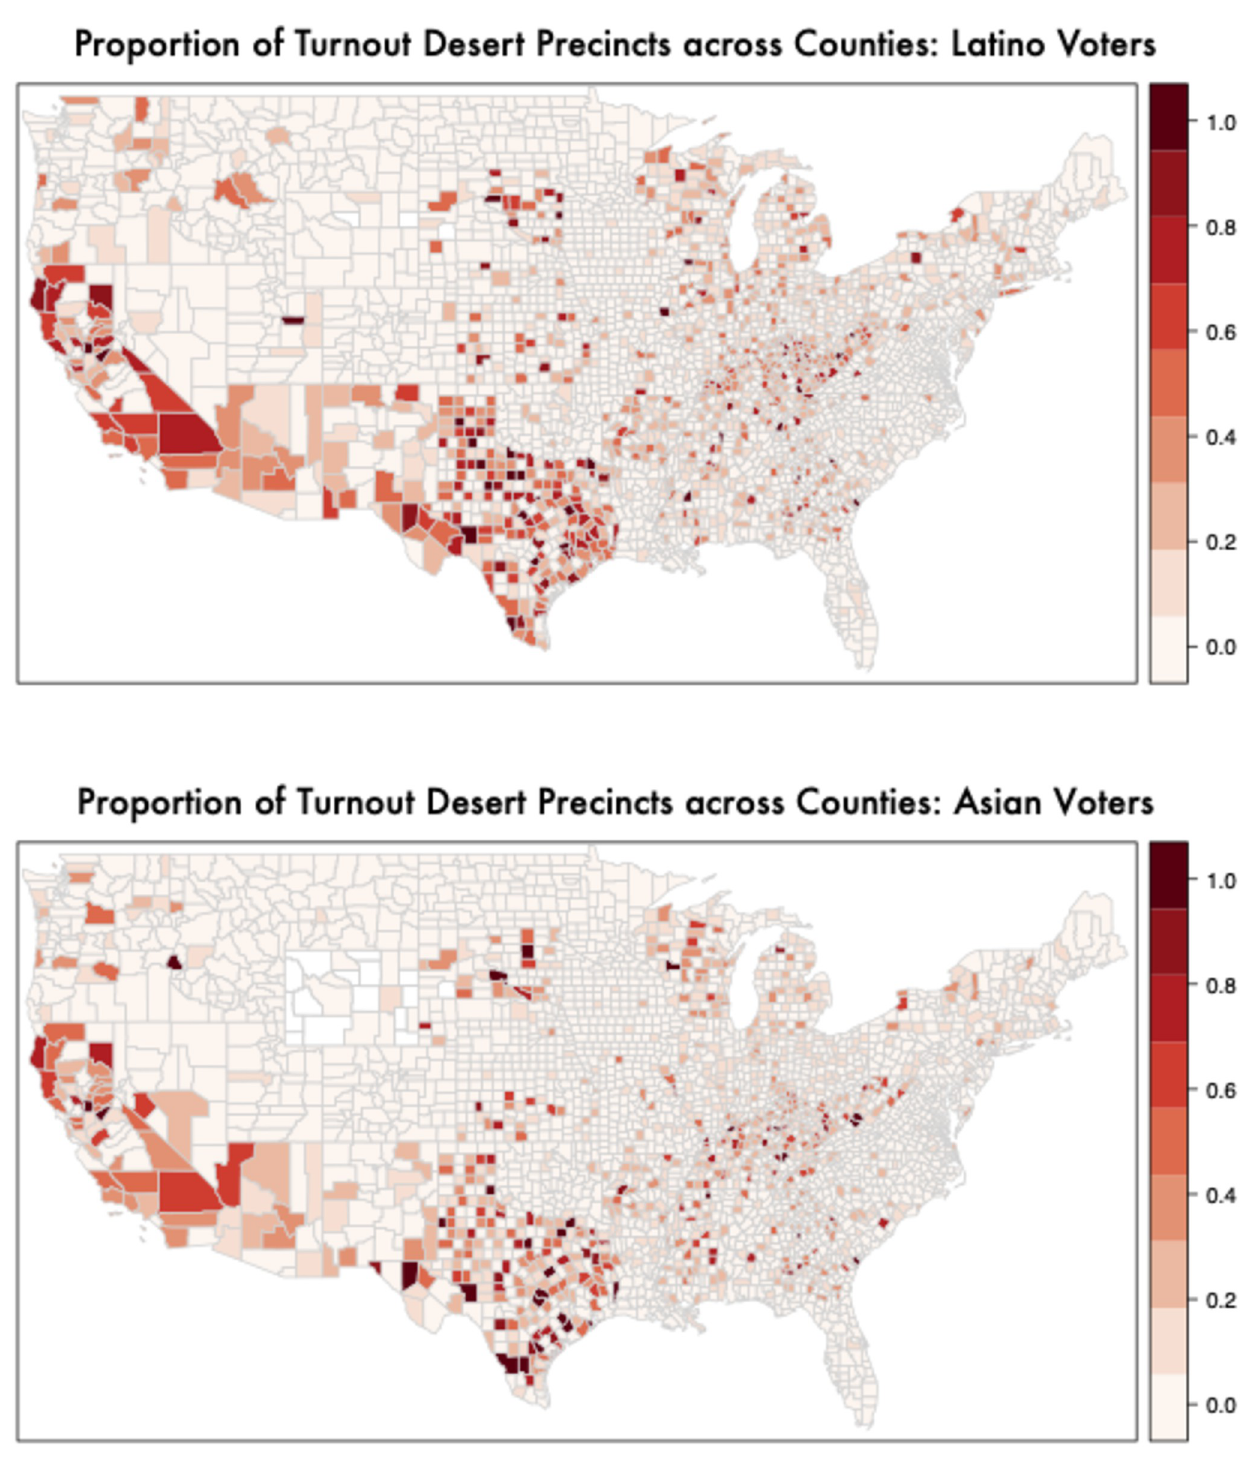
Fig 4. Mapping turnout deserts by racial groups (2) proportion of turnout desert precincts in a county by race (i.e. 1 standard deviation below the national average in voter turnout in 2016). The top panel shows among precincts where Hispanic voters live and the bottom panel shows precincts where Asian voters live. Hispanic (36.2%) individuals are more than 3 times more likely to live in a turnout desert precinct than white voters (8.3%). Asian citizens are 2.6 times more likely to live in a turnout desert precinct than white voters. Minorities’ turnout deserts are spread across large/urban and small/rural locations. S13-S20 Figs in S1 File show similar maps for all groups in 2014 in addition to different definitions of turnout deserts.